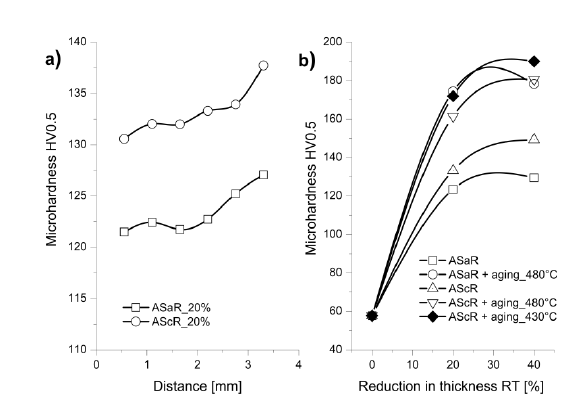
Figure 6: Microhardness of CuCrZr: a) across the sample of thick- ness and b) microhardness after rolling and